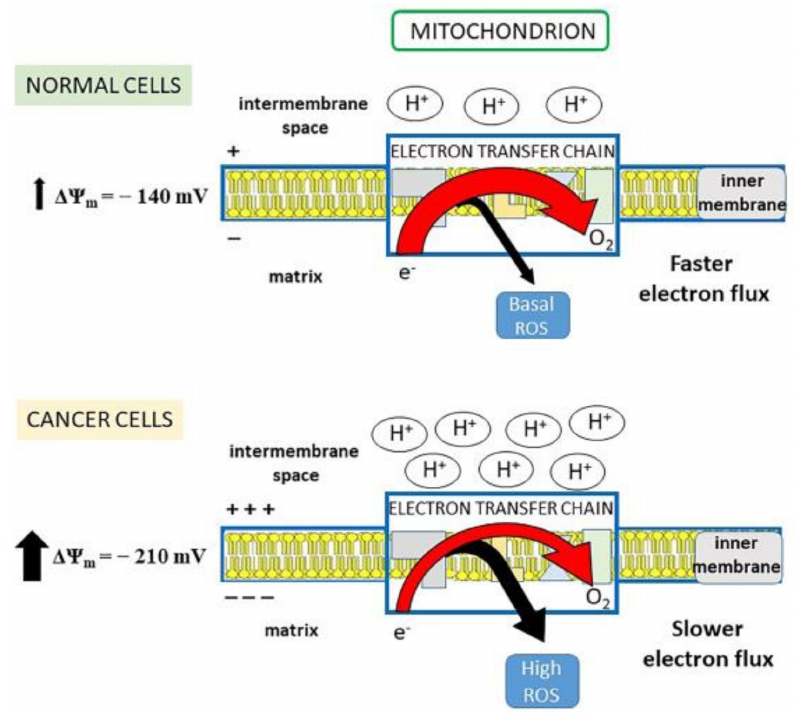
Figure 1. Electron flux in electron transport chain (ETC) and mitochondrial (mt)ROS production. Normal cells: the physiological electron flux in ETC determines robust proton pumping from the matrix to the intermembrane space and maintains stable negative mitochondrial membrane potential ( ∆ ψ m = − 140 mV). In this situation, electron transfer to O 2 is fast and the electron leakage for ROS generation is small (basal ROS production). Cancer cells: the electron transfer to O 2 is slow because the associated proton pump is impaired by the fact that protons must be pumped against a stronger electrochemical force ( ∆ ψ m = − 210 mV). Thus, a larger number of electrons leaks out ETC, increasing ROS